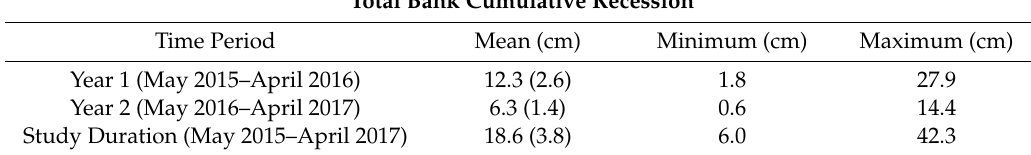
Table 5. Total Bank cumulative mean recession for Year 1, Year 2, and study duration, Walnut Creek, Iowa. Results derived from individual bank cumulative recession data. Numbers in parentheses represent standard error.